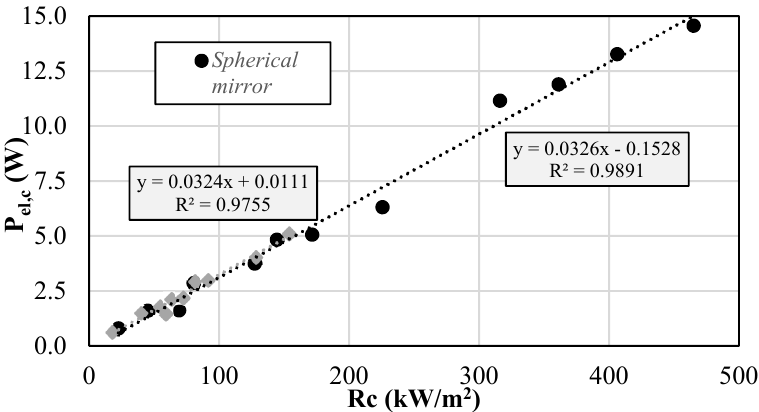
Figure 13. Increase of the TJ cell electrical power as a function of the concentrated solar radiation (R c ) for the two optics. Table 4. Values of the coefficients of the experimental equations describing the trends of T c and P el,c for the two optics. Equation α β γ δ R 2 (7) Fresnel